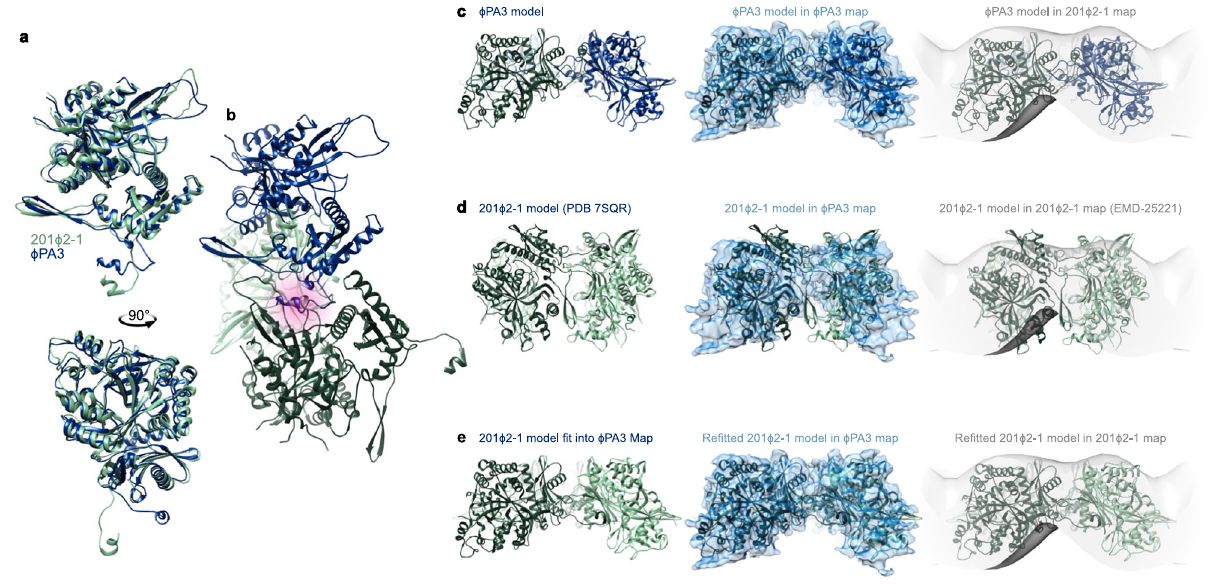
Fig. 5 | PhuN proteins from ϕ PA3 and 201 ϕ 2-1 share similar structures. a Top and side views of an overlay of the ϕ PA3 (blue) and 201 ϕ 2-1 17 (green) monomeric subunits. The overlay was determined by fi tting the monomers into the blue ϕ PA3 EM density shown in panels c – e . The greatest backbone differences between the models reside in the extended positioning of the N-terminal resi- dues, β -Hairpin, and a resolved fl exible loop. b The binding pockets utilized by both ϕ PA3 and 201 ϕ 2-1 proteins are the same, as highlighted in pink. This was determined by fi tting the dark green 201 ϕ 2-1 subunit into the ϕ PA3 map while retaining the light green subunit to preserve the N-terminal tail interaction. The